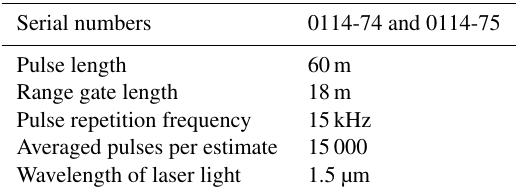
Table 1. Instrument specification and settings of the Doppler lidars. From top to bottom: serial number of the forest and desert lidar, pulse length of the laser pulse at full width at half maximum, range gate length, pulse repetition frequency, number of averaged pulses for a backscatter coefficient profile, and the wavelength of the emit- ted laser pulse (short wavelength